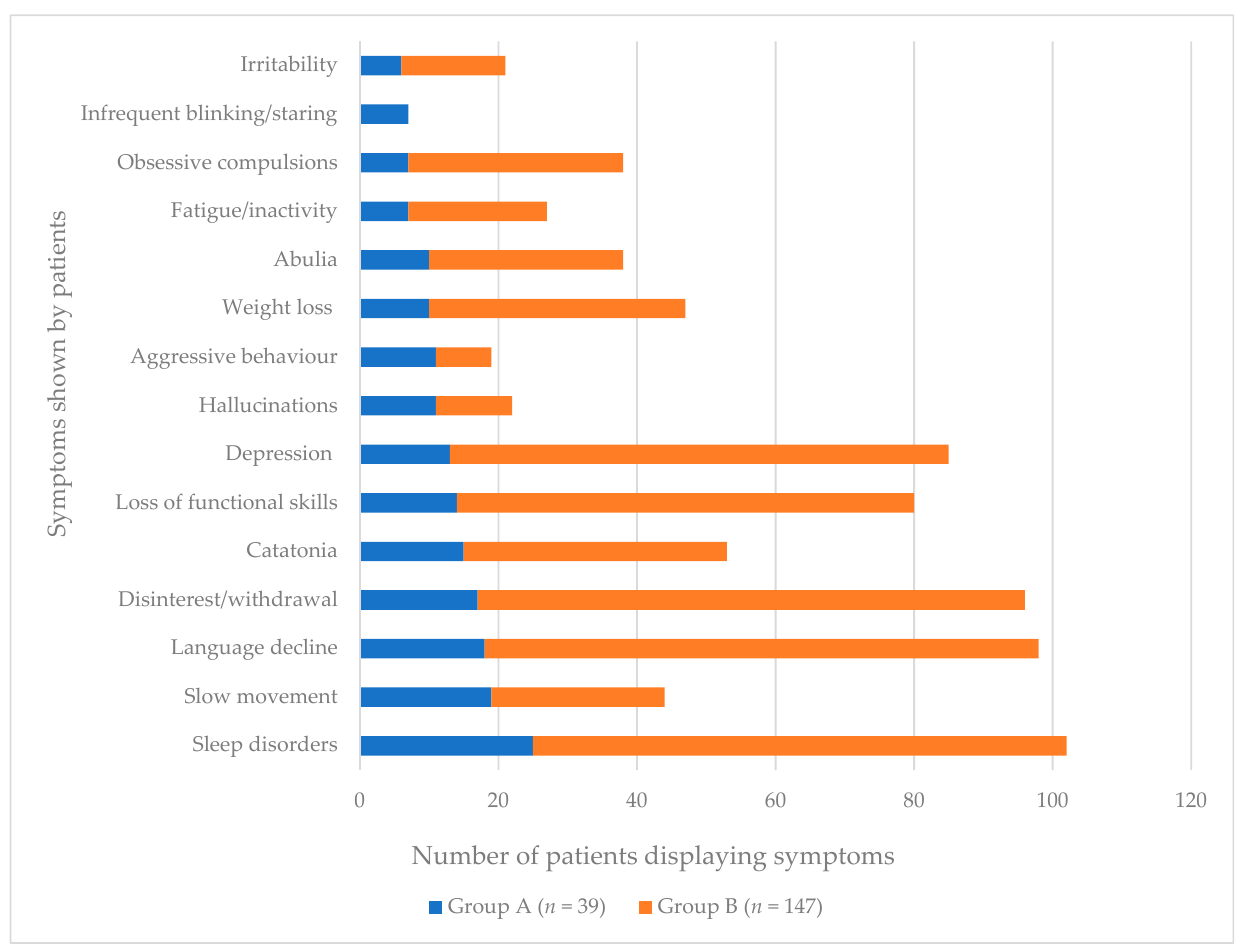
Figure 2. Number of cases in Group A (case study patients) and Group B (cohort study patients) displaying most prevalent symptoms of IRDS.